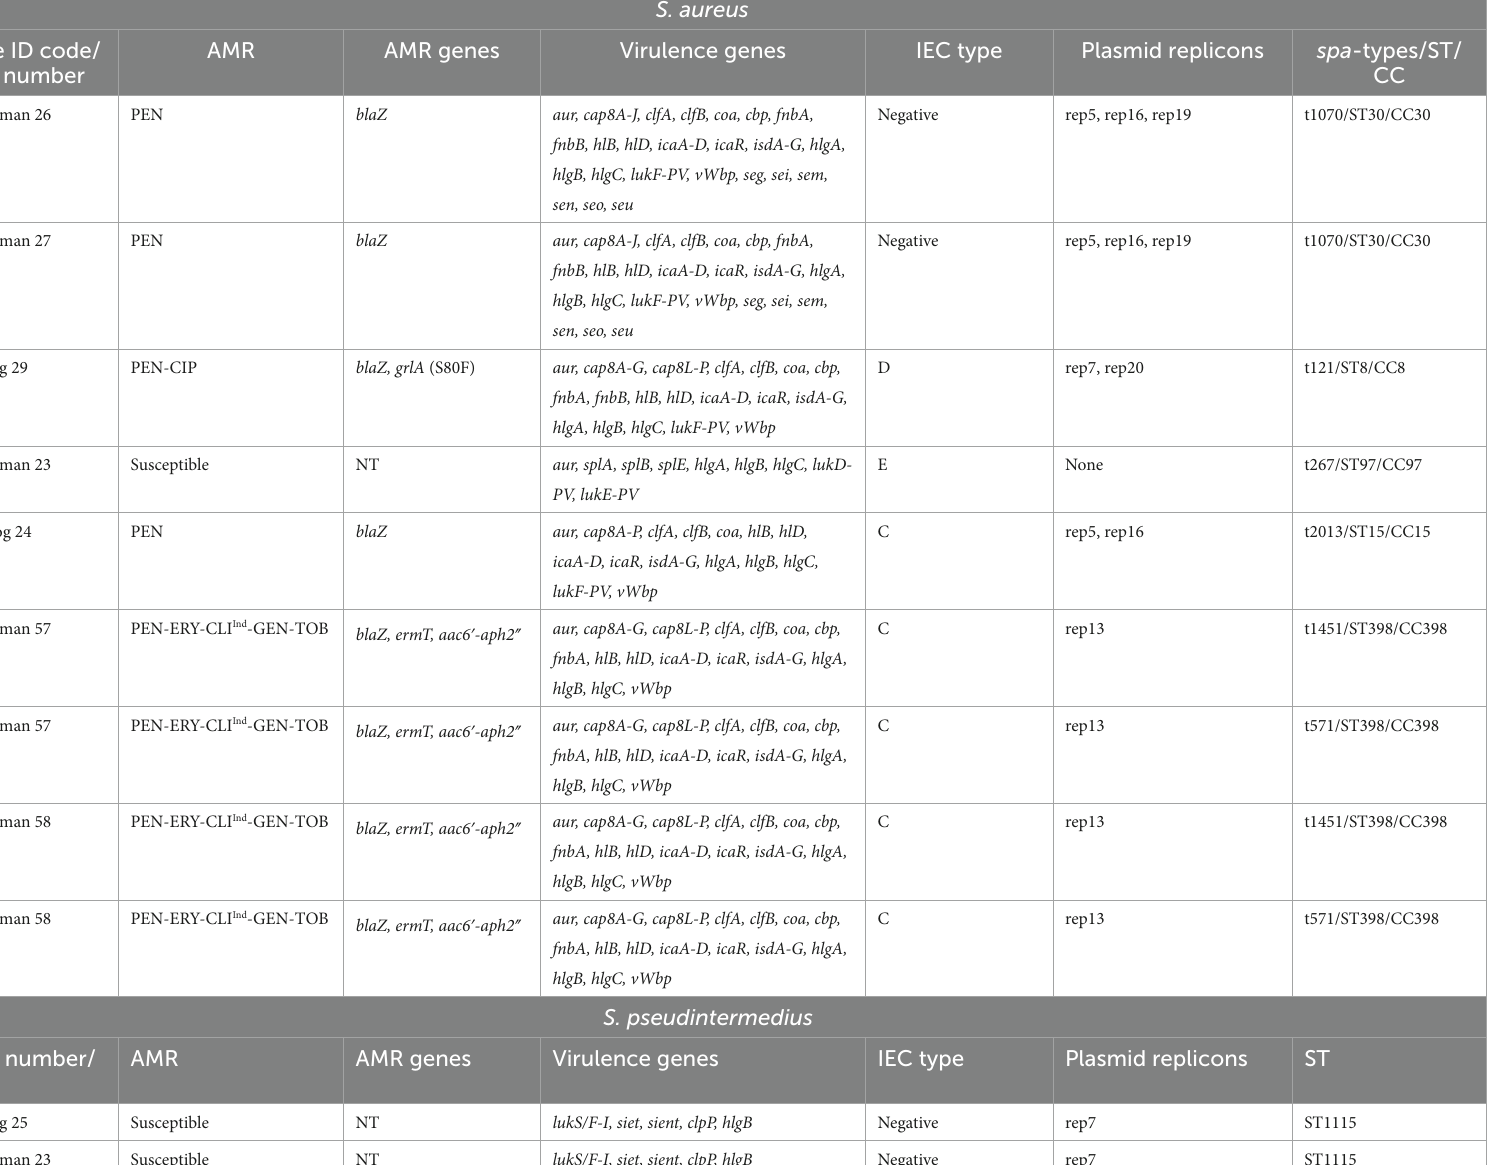
TABLE 4 Genetic lineages, virulence and AMR genes of CoPS isolates among households with both dog and human carriers. Household ID N o